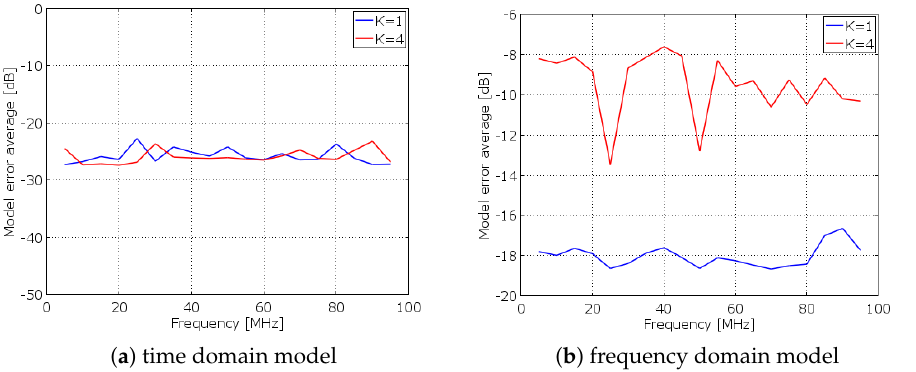
Figure 3. Experimental results of ME in the RD for ( a ) the time domain model and ( b ) the frequency domain model